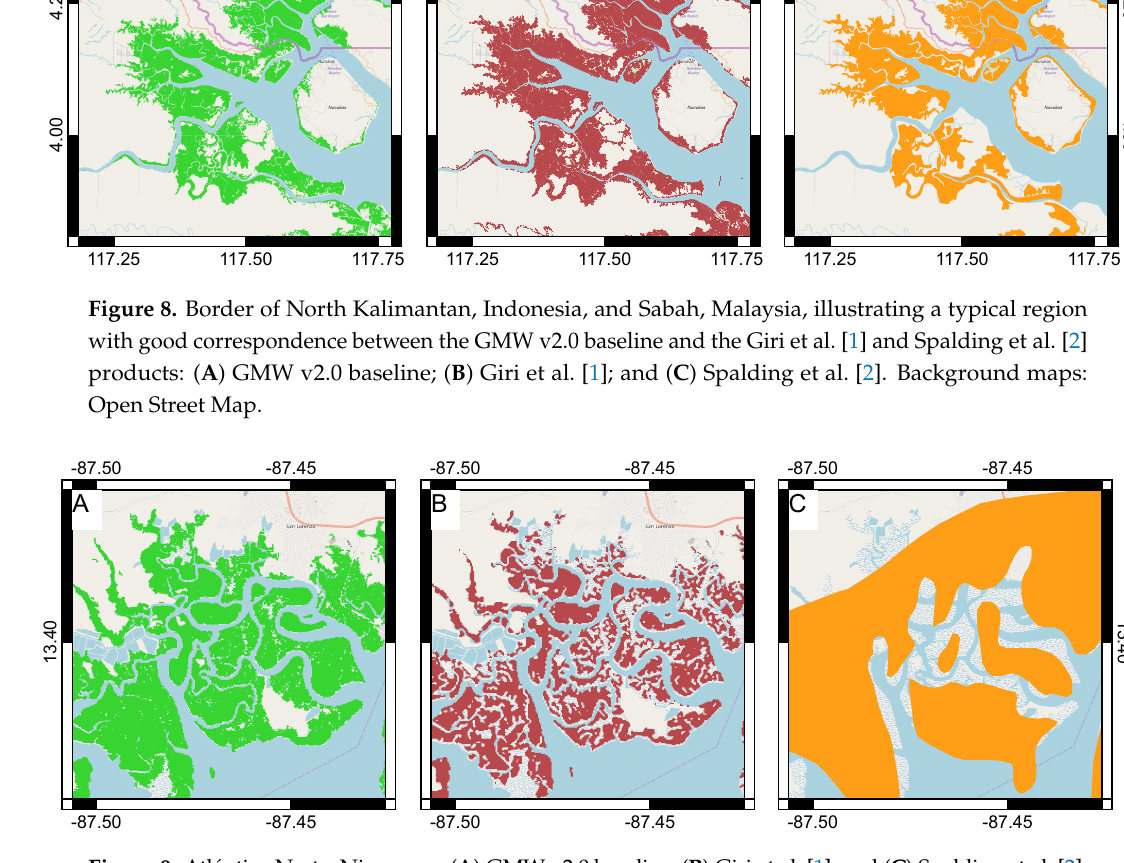
Figure 9. Atlántico Norte, Nicaragua: ( A ) GMW v2.0 baseline; ( B ) Giri et al. [1]; and ( C ) Spalding et al. [2], illustrating a region where the Spalding et al. [2] is generalised and overestimates the mangroves extent compared to Giri et al. [1] and the GMW v2.0 baseline. In this example, the Giri et al. [1] product has more detail than the GMW v2.0 baseline. Background maps: Open Street